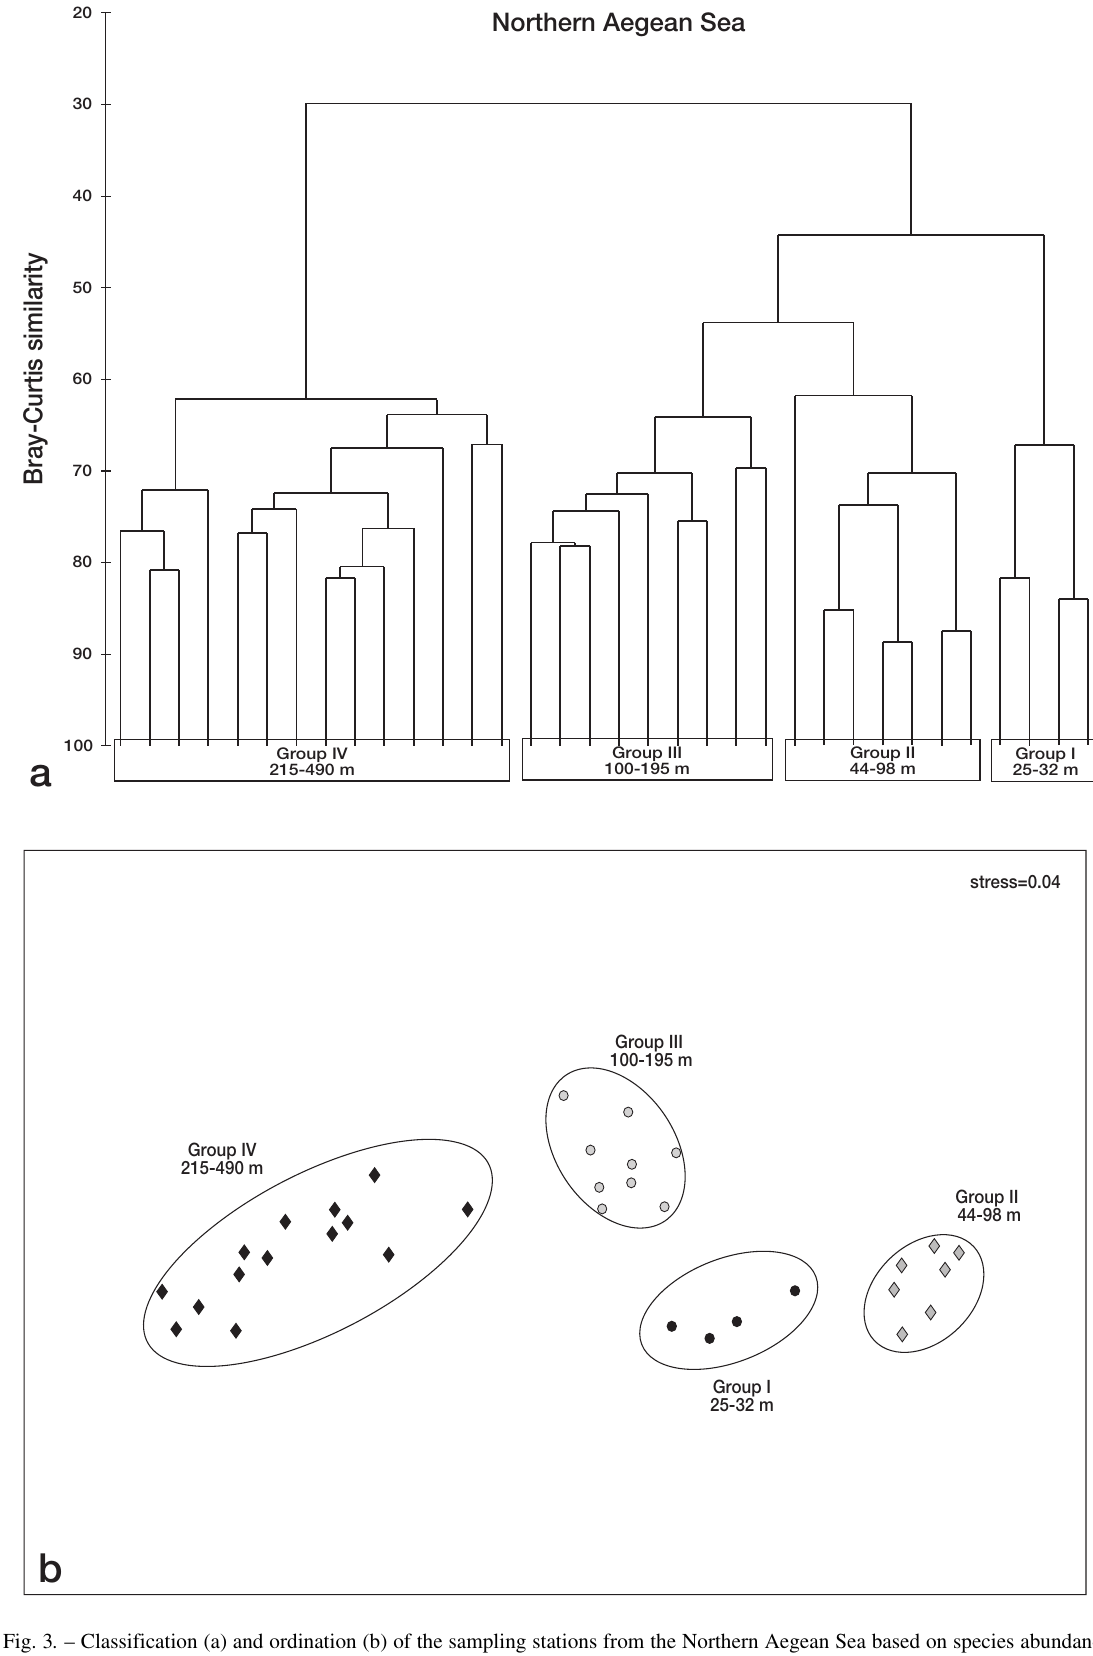
Fig. 3 . – Classification (a) and ordination (b) of the sampling stations from the Northern Aegean Sea based on species